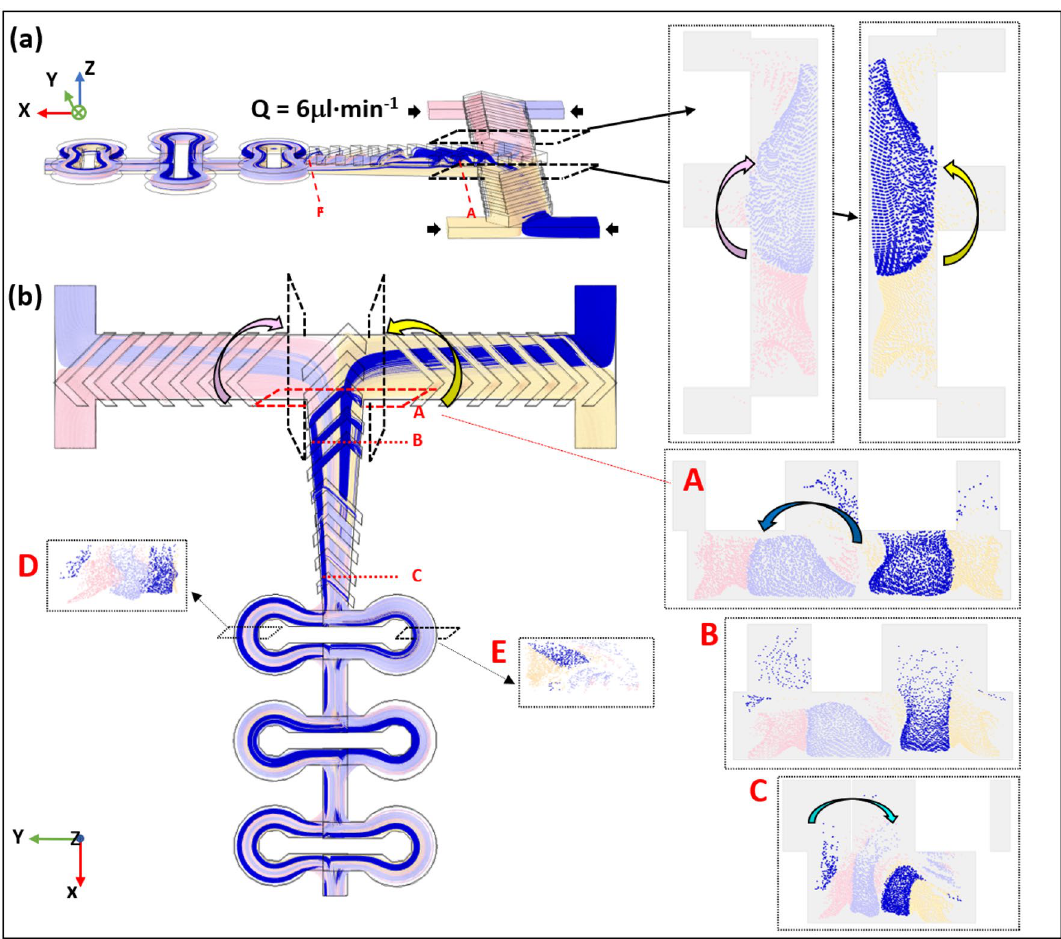
Figure 7. Particle trajectories along the mixing channel from side (a) and top (b) views. Poincaré maps of different cross-section at locations A–E along the channel are shown in the